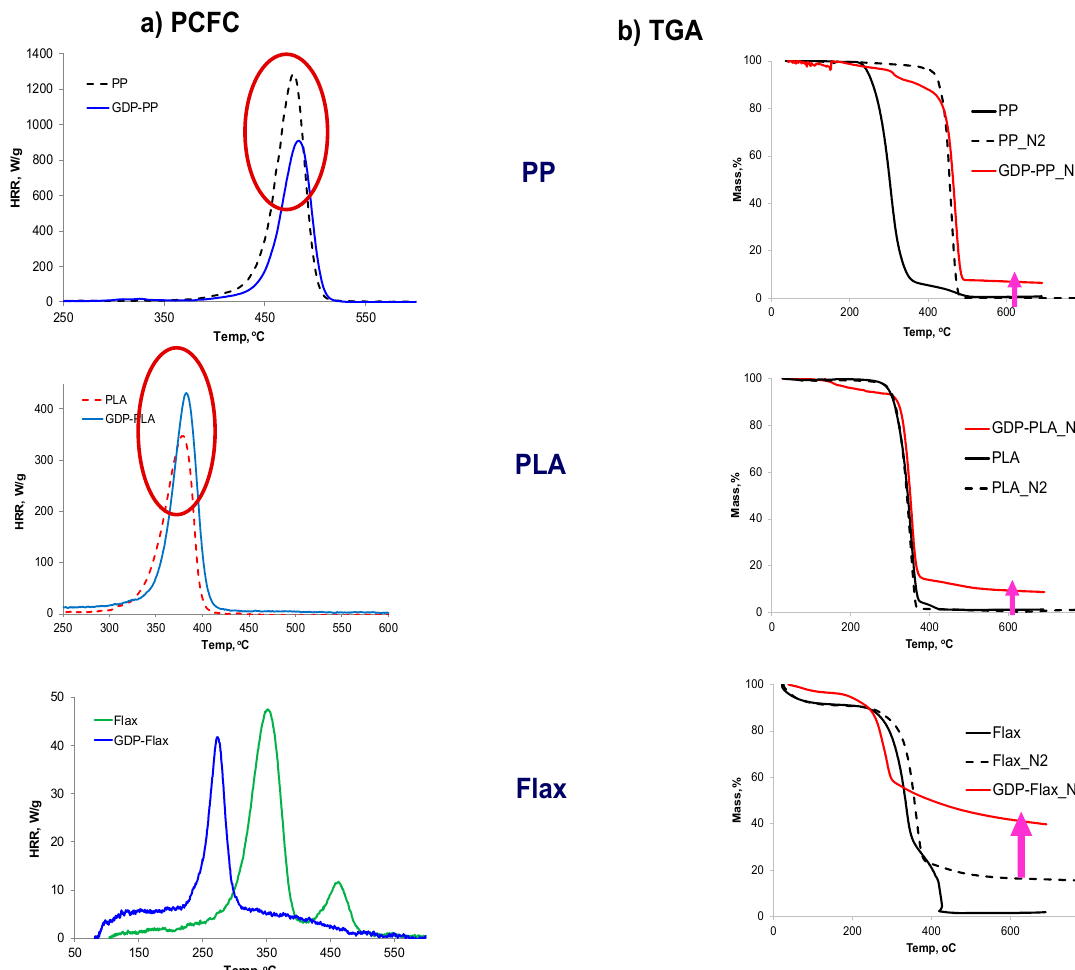
Figure 7. ( a ) PCFC and ( b ) TGA curves (in nitrogen) of GDP treated PP, PLA, flax, flax/PP, and flax/PLA.